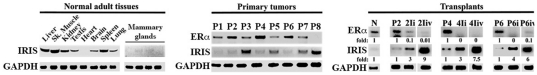
BRCA1-IRIS mRNA expression in NMU-induced primary and invasive breast tumors.(A) RT/PCR analysis of rat BRCA1-IRIS mRNA expression in normal adult rat tissues (left) and several adult rat mammary glands (right). (B) RT/PCR analysis of the expression of ERα and BRCA1-IRIS mRNAs in several primary rat breast tumors generated flowing NMU treatment (P1–P8). (C) RT/PCR analysis of the expression of ERα and BRCA1-IRIS mRNAs in normal gland (N), three primary tumors P2, P4 and P6 and the first (2Ii, 4Ii and 6Ii) or the fourth (2Iiv, 4Iiv and 6Iiv) invasive tumors generated following serial transplantation of the mentioned primary tumors.